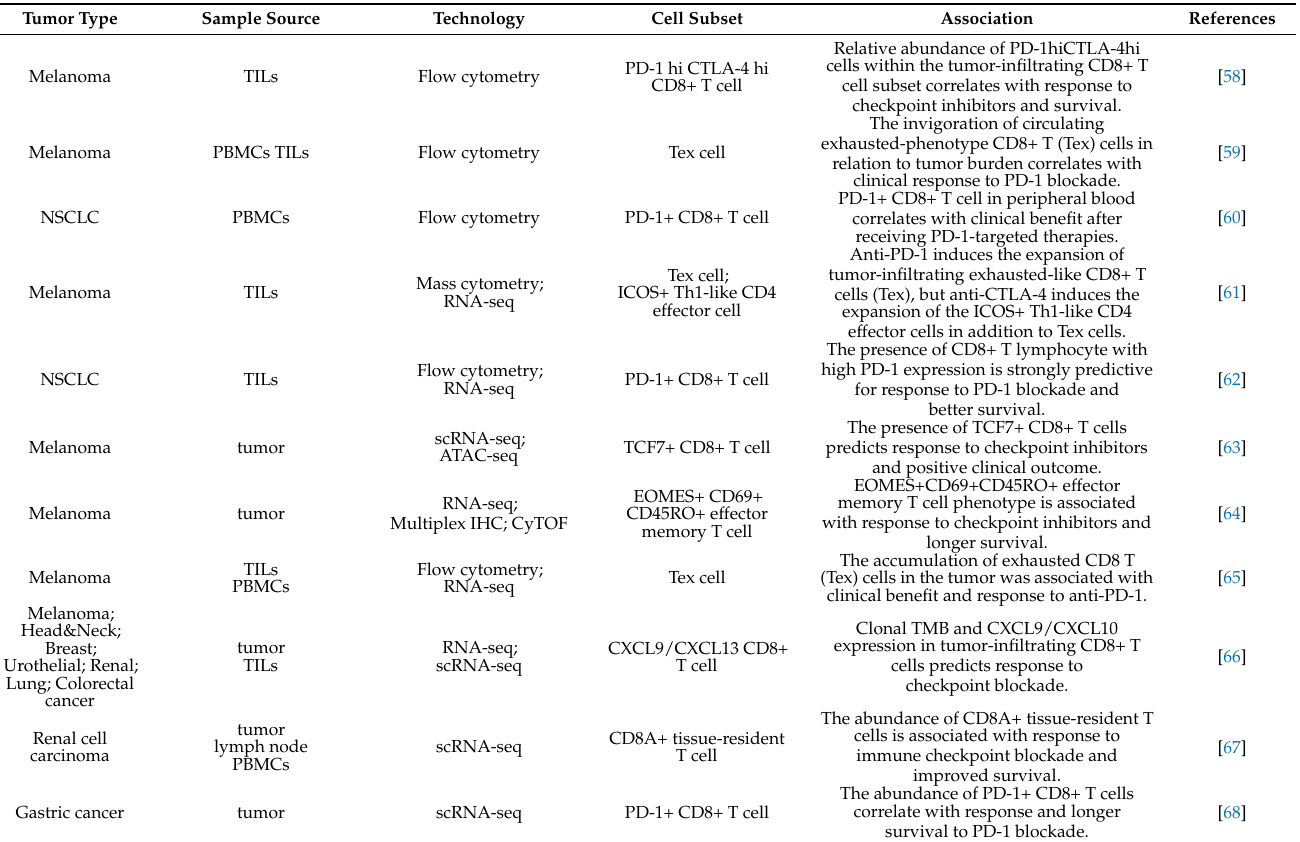
Table 3. Single-cell studies identifying immune cells associated with response to immune checkpoint